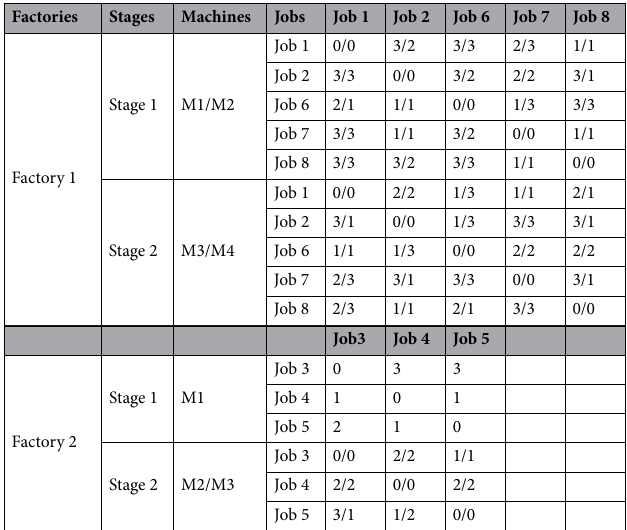
Table 3. Sequence dependent setup times.